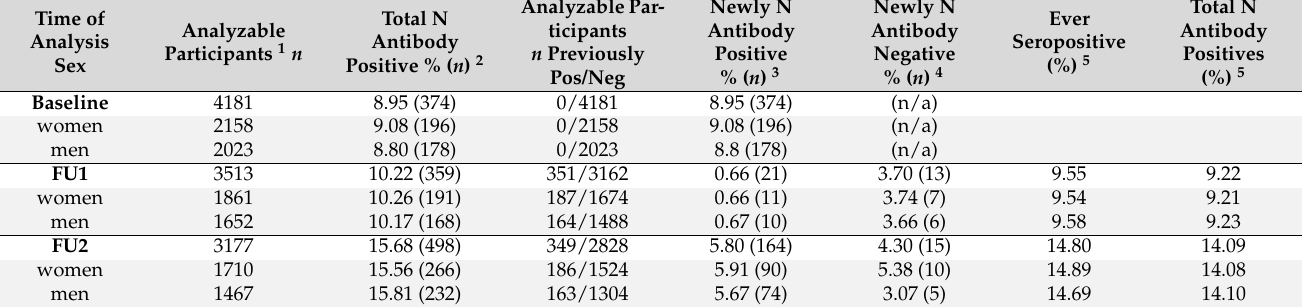
Table 2. Crude N-test seropositivity among analyzed participants and changes over time. Shown are the number of total N-antibody positives, newly seropositive, and newly seronegative participants for N-protein specific antibodies at baseline (June 2020), at FU1 (November 2020), and at FU2 (April 2021). Also shown is the percentage of the according participants group as well as ever N-seropositives and total N-seropositives.